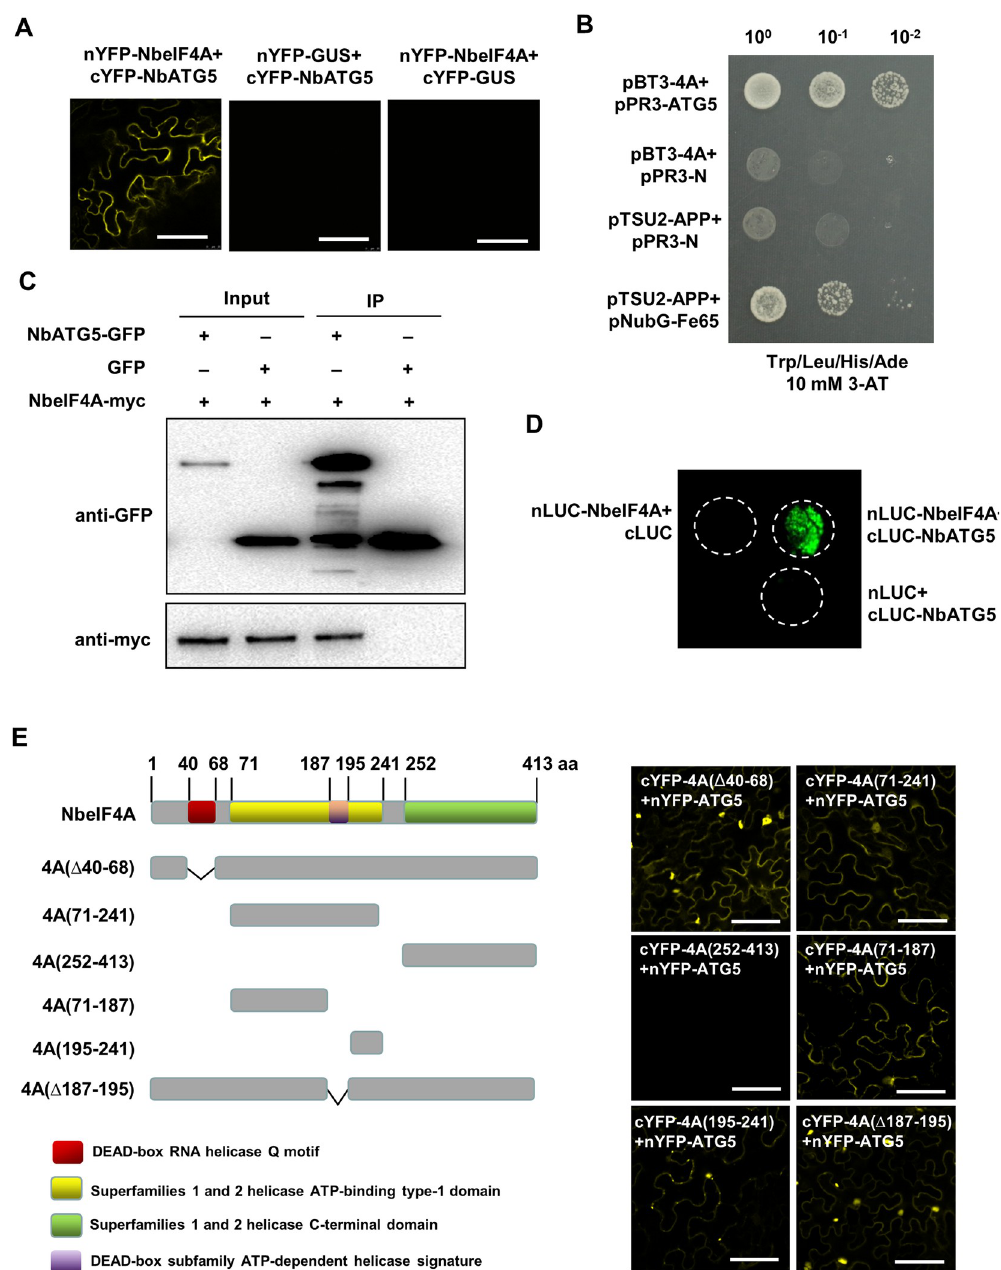
Fig 4. Nb eIF4A interacts with Nb ATG5. (A) Nb ATG5 and Nb eIF4A interaction, as tested by BiFC assay in cells expressing nYFP-4A ( Nb eIF4A) and cYFP-ATG5 ( Nb ATG5), and in control cells expressing nYFP-GUS and cYFP-ATG5, or cYFP-ATG5 and cYFP-GUS, under confocal microscopy. Bars, 20 μ m. (B) Nb eIF4A interacts with NbATG5 in a Y2H assay. pBT3-4A ( Nb eIF4A), pPR3-ATG5 ( Nb ATG5), pPR3-N, positive control, or negative control constructs were co-transformed into yeast cells. The samples were plated onto selective medium lacking tryptophan, leucine, histidine, and adenine (SD/- Trp/-Leu/-His/-Ade) with 10 mM 3-AT. (C) Co-IP analysis of the interaction between Nb ATG5 and Nb eIF4A. Leaf tissues infiltrated with Agrobacterium cell suspensions carrying various constructs were harvested at 60 hpi. Total proteins were immunoprecipitated with anti-GFP beads. Input and immunoprecipitated protein (IP) were analyzed by immunoblot analysis with anti-GFP and anti-myc tag antibodies. (D) LCI assays of the interaction between Nb ATG5 and Nb eIF4A in N . benthamiana . Luminescence was measured in the infiltrated zone expressing nLUC-4A and cLUC- Nb ATG5, nLUC-4A and cLUC, cLUC- Nb ATG5, or nLUC. (E) BiFC assay of the potential interactions between Nb ATG5 and Nb eIF4A mutants. Schematic diagrams of the Nb eIF4A mutants are shown on the left. Bars, 20 μ m.